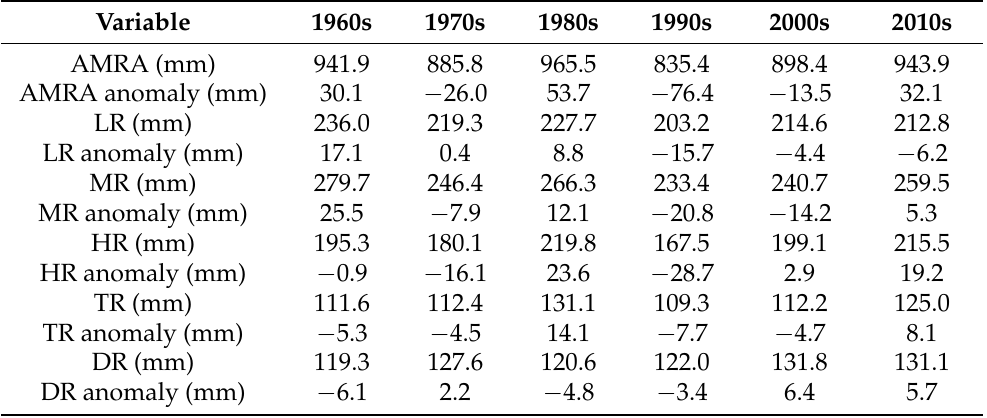
Table 3. The regionally averaged annual mean rainfall amount (AMRA), light rainfall (LR), moderate rainfall (MR), heavy rainfall (HR), torrential rainfall (TR), and downpour rainfall (DR) in the QMs in different